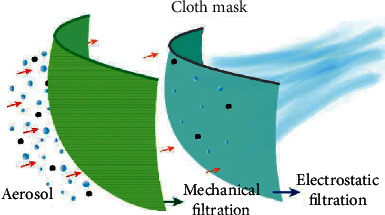
A new design of homemade cloth masks from common fabric materials. Reproduced with permission from Ref. [95]. Copyright 2020, the American Chemical Society.